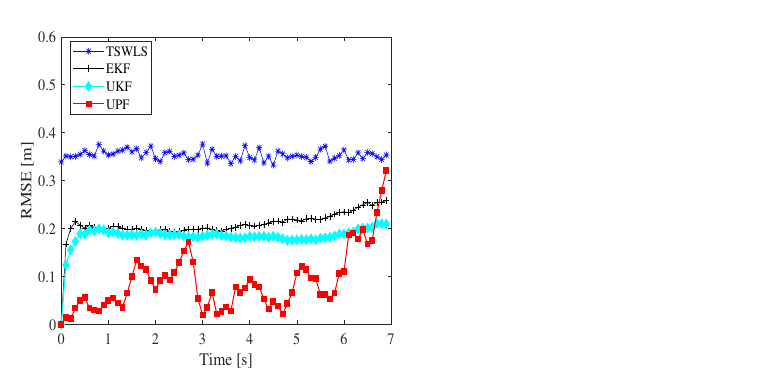
Figure 11. The RMSE of different algorithms in NLOS scenario ( σ θ